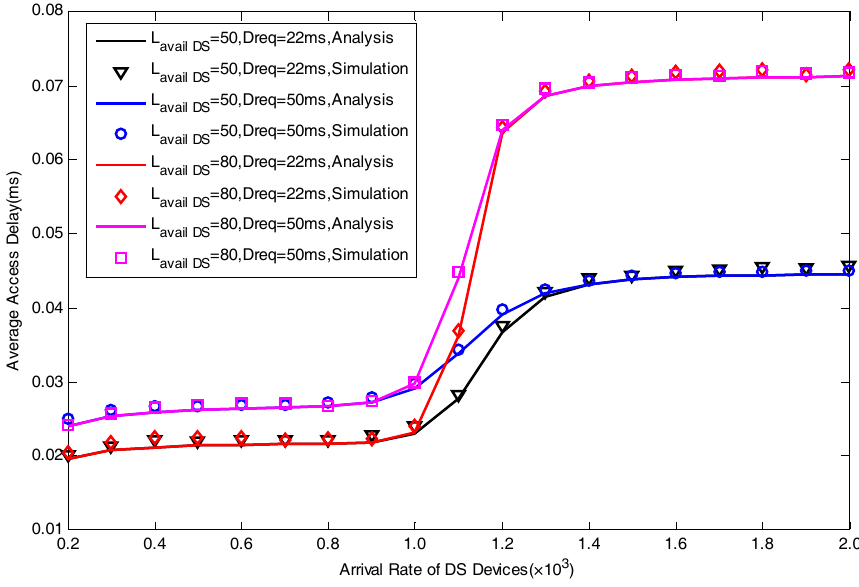
Figure 4. Average Access Delay with different L avail _ DS and D req .